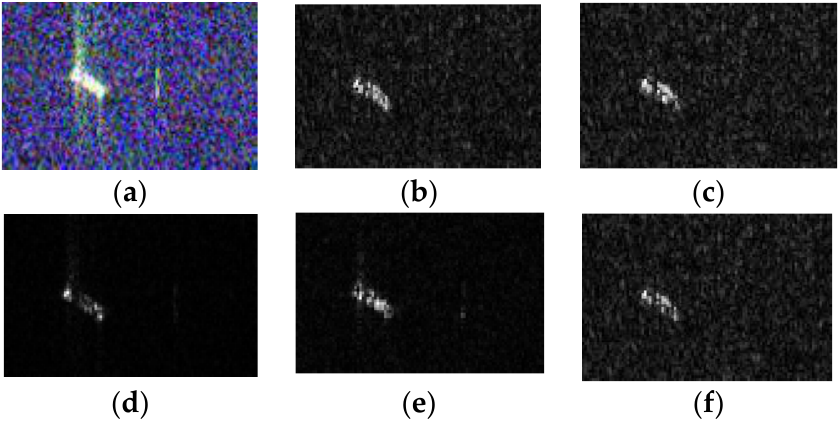
Figure 8. ( a ) Pauli pseudo-color image; ( b ) HH; ( c ) VV; ( d ) HV; ( e ) HH − VV ; and ( f ) HH + VV. Table 3. Peak signal-to-clutter ratios of the two ships in different image channels (SCR/dB).